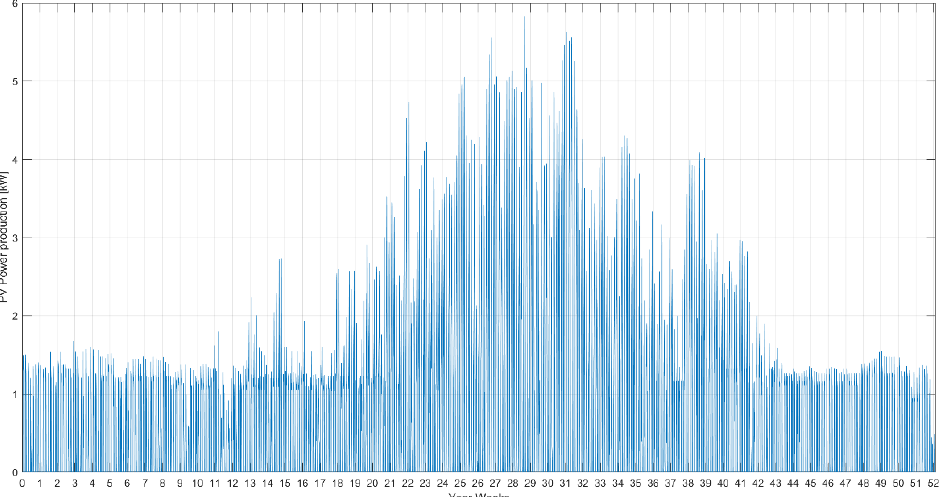
Figure 5. Estimation of power that can be produced by a residential PV system during the year, in the average Italian context.